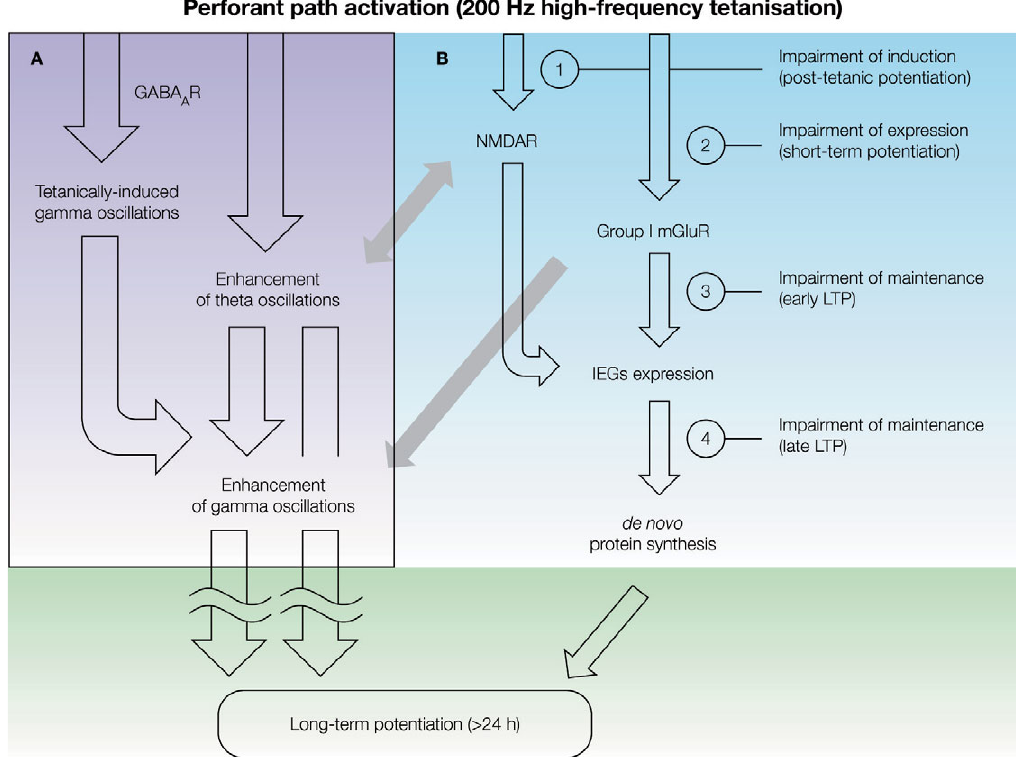
Figure 2 | A schematic representation of the consequences of high-frequency tetanisation that occur on the network and cellular levels, and lead towards long-term potentiation of synaptic transmission. (A) Strong afferent stimulation results in an enhancement of both theta and gamma oscillations, which occurs within 5 min interval after tetanisation and can be mediated via GABARs, NMDARs and mGluRs. (B) Tetanisation-triggered activation of both ionotropic and metabotropic glutamate recep- tors is followed by the expression of plasticity-related immediate-early genes (IEGs) and protein synthesis, which can underlie structural synaptic reorganisation and long-term increase in synaptic effi cacy. Experimental procedures that inhibit the induction, expression or maintenance of LTP can result in impairment of post-tetanic potentiation, STP, early LTP or late LTP (1–4, respec- tively). Grey arrows denote possible links between NMDAR and mGluR activation and facilitation of network activity in theta and gamma frequency